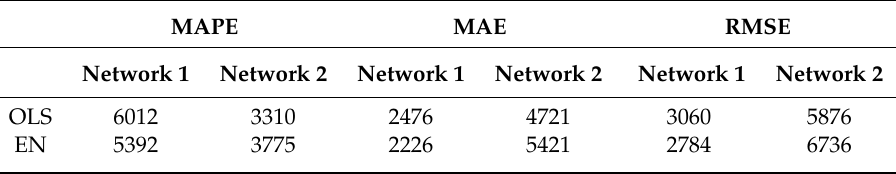
Table 3. MAPE, MAE and RMSE